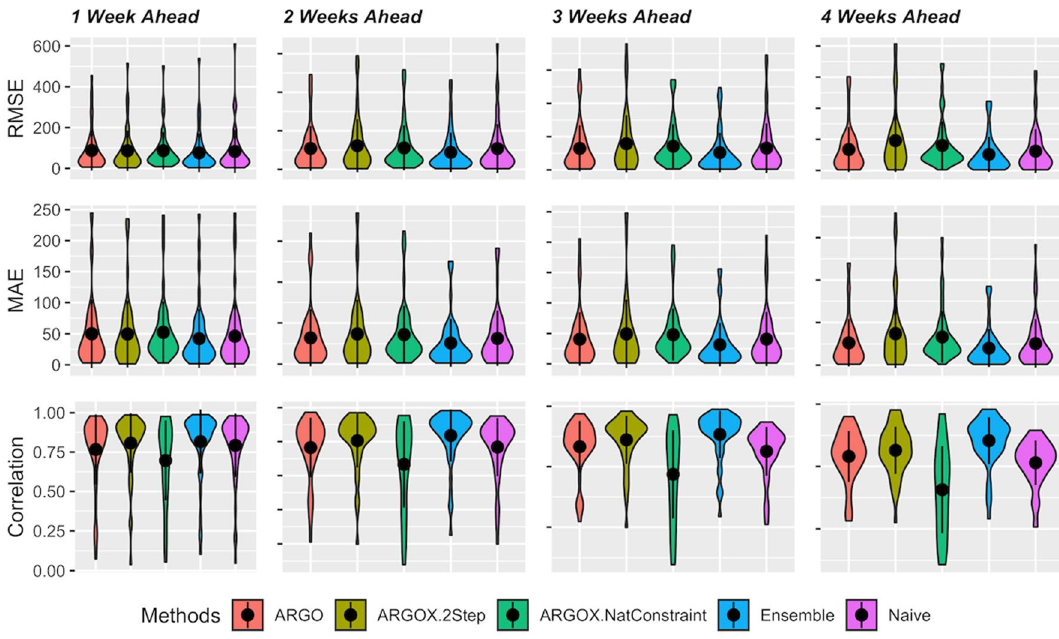
Figure 7. The distribution of values for each metric for each model, over the 51 states for 1 to 4 weeks (from left to right) ahead predictions during the period from 2020-07-04 to 2022-03-05. The embedded black dot and vertical line indicate mean and 1 standard deviation range. Average of each error metric across 51 states are reported in Table 2.